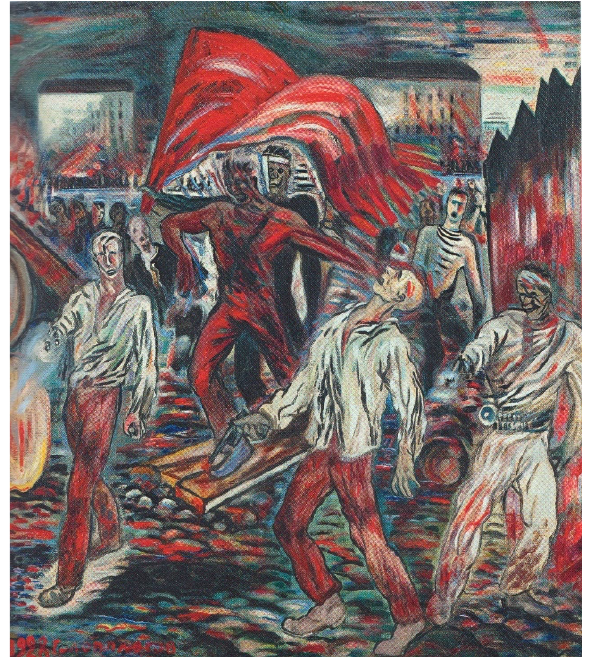
Figure 8. B. Golopolosov. The Struggle for the Red Banner . 1928.